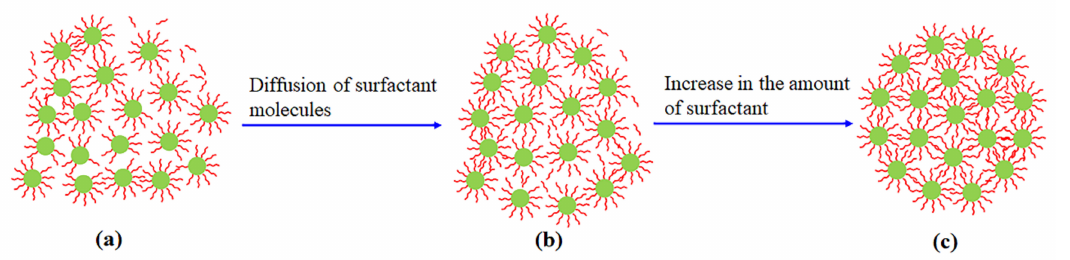
Figure 10. Aggregation schematic of spherical-like and spherical WO 3- x aggregates. ( a ) irregular structure; ( b ) submicro-spherical-like structure; ( c ) submicro- or micro-spherical